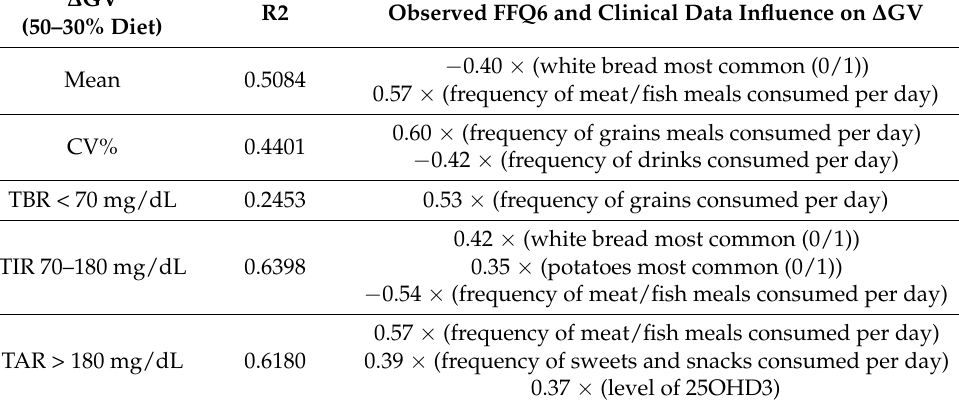
Table 4. Coefficient determination (R 2 ) and beta coefficients for multivariate linear regression mod- els for change in selected glycaemic variability indices between the diets ( Δ GVs).